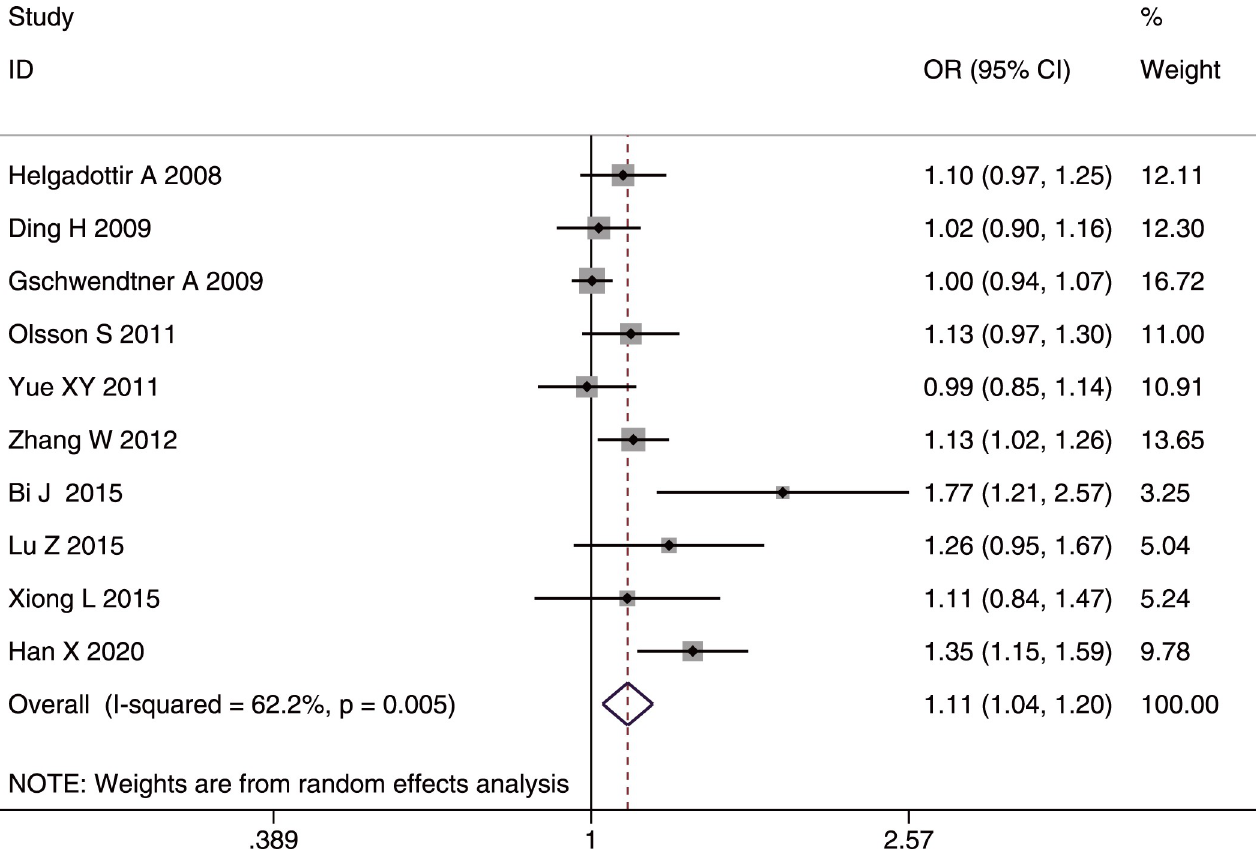
Fig 3. Forest plot of rs10757278 allele frequency (G vs. A) in the whole studied population.